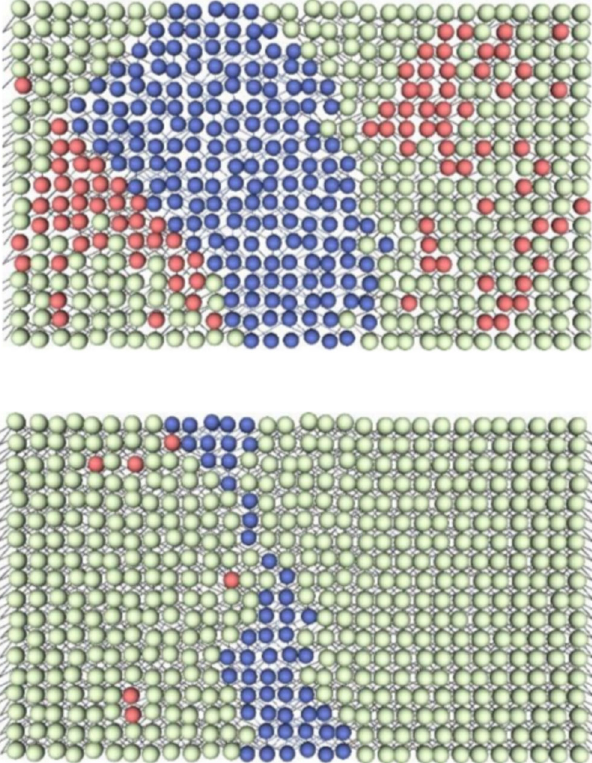
FIG. 10. Adaptation of thermal stability. Extreme configura- tions, with low (50%, left) and high (95%, right) bond density, solve problem T .